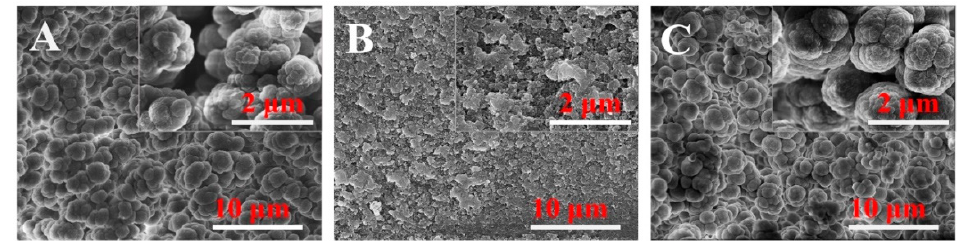
Figure 1. SEM images of three fiber coatings. ( A ) SMIP; ( B ) AM-MIP; ( C ) SNIP.